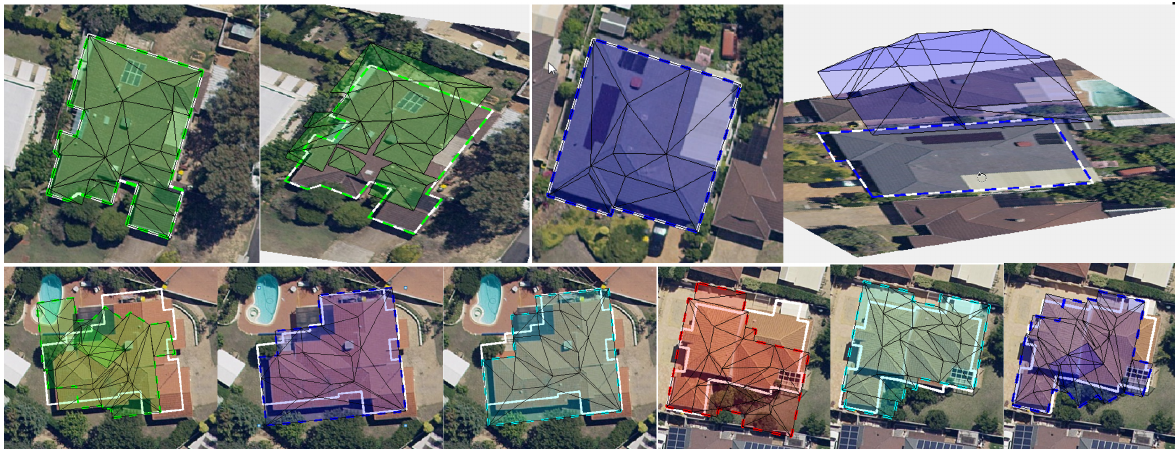
Figure 2. Examples of successful (top row, 2D and 3D views) and not successful (bottom row) results of geo-typical modeling.